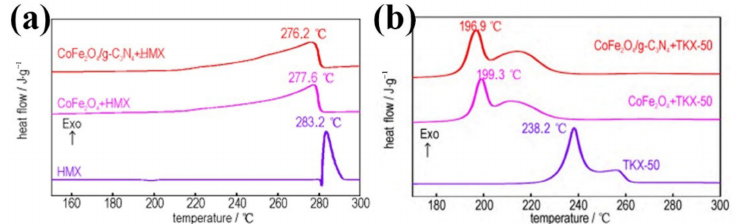
Figure 26. DSC curves of ( a ) HMX, CoFe 2 O 4 +HMX and CoFe 2 O 4 /g-C 3 N 4 +HMX; ( b ) DSC curves of